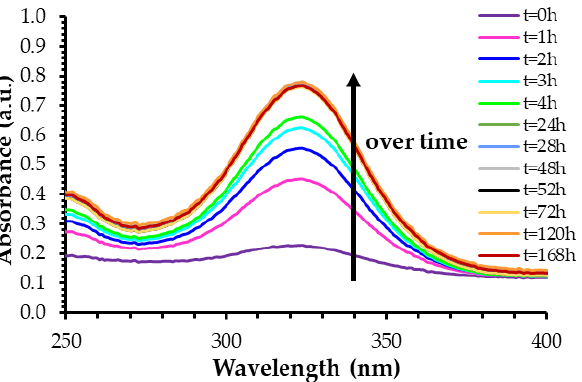
Figure 1. UV–visible spectra of the dialysate containing released ketorolac from AuNPs. In this example, ketorolac was loaded for three days at the AuNP-to-ketorolac molar ratio of 1:100. Spectra were taken for 7 days (equivalent to 168 h).